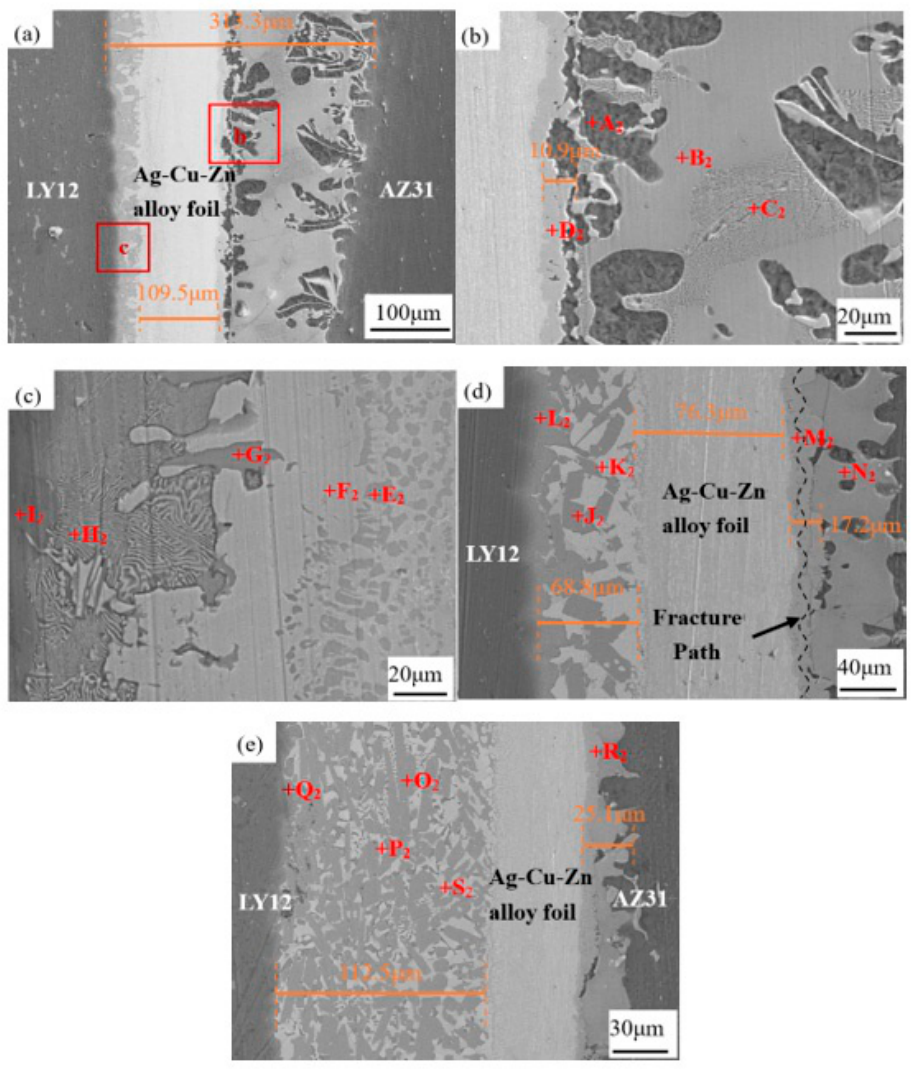
Figure 3. Microstructure evolution of the joints with increasing UST at 440 °C: ( a – c ) 5 s; ( d ) 10 s; and ( e ) 15 s. Panel ( b ) refers to area b in ( a ) and panel ( c ) refers to area c in ( a ).